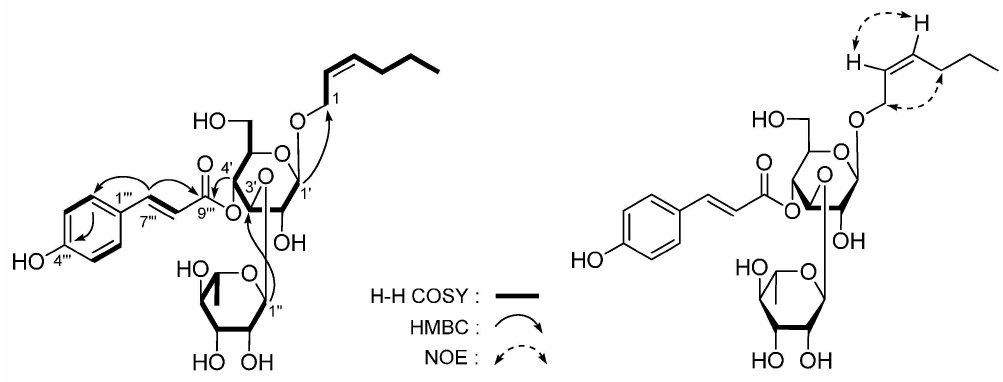
Figure 5. The main 1 H- 1 H COSY, HMBC and NOE correlations of 3 .